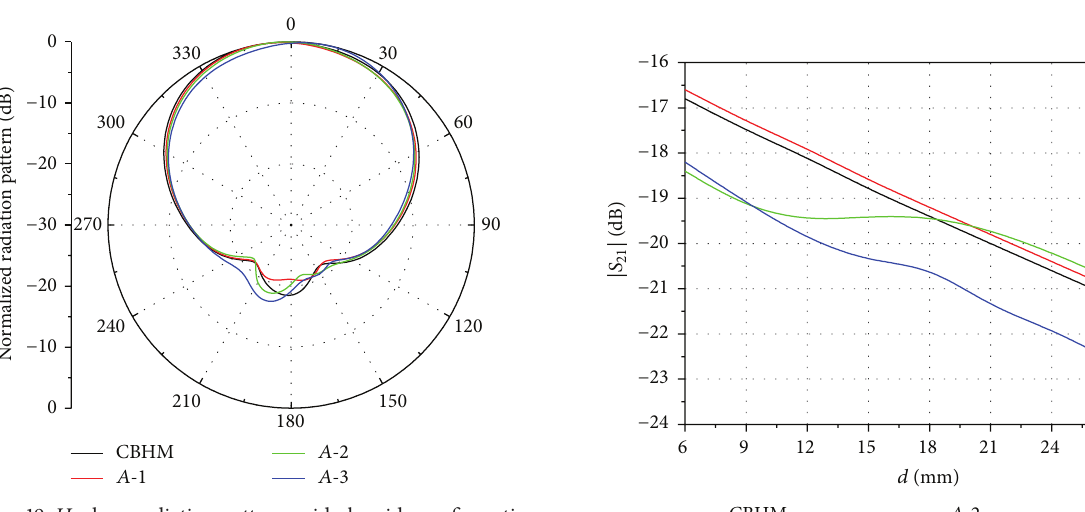
Figure 19: H -plane radiation patterns: side-by-side configuration.